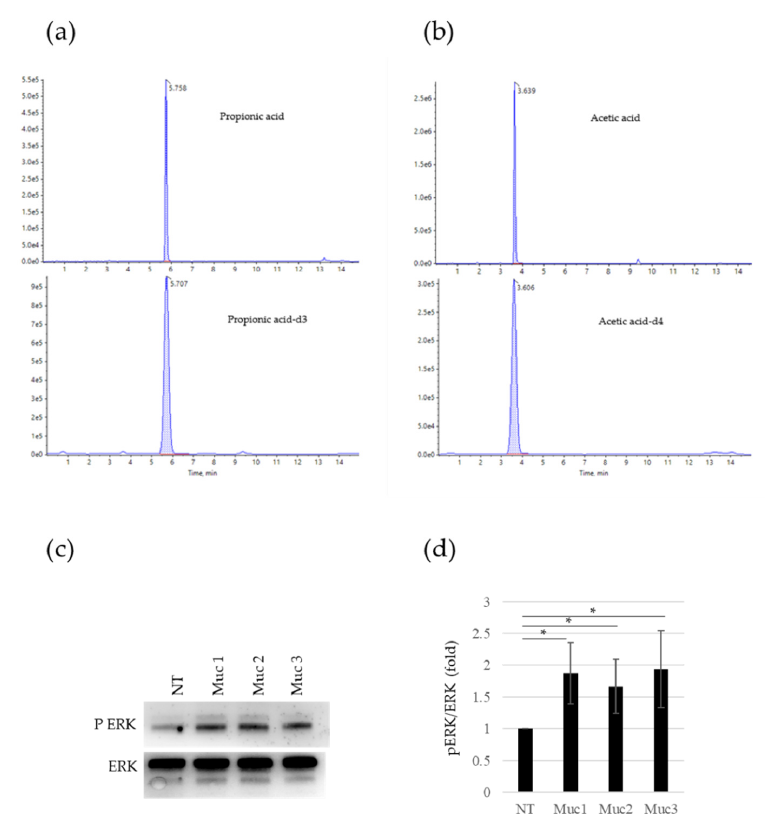
Figure 4. Activation of sperm cells by SCFAs in cervical mucus. ( a ) Plot shows a typical multiple- reaction-monitoring chromatogram of propionic acid (266.1–210.0) at the top and [2H 3 ] propionic acid (269.2–210.0) at the bottom of a cervical mucus sample with propionic acid. ( b ) Plot shows a typical multiple-reaction-monitoring chromatogram of acetic acid (255.1–209.9) at the top and [2H 4 ] acetic acid (255.1–211.0) at the bottom of a cervical mucus sample with acetic acid. ( c ) Representative Western blot (WB) analysis of pERK and total ERK protein in sperm cells after in vitro incubation for 10 min with cervical mucus obtained from three different healthy, fertile women. ( d ) Histogram shows the ratio of densitometric values of pERK to total ERK in sperm cells after in vitro incubation with cervical mucus. The densitometric value of untreated sperm cells (NT) is arbitrarily set to 1. Mean ± SD of three independent biological replicates are shown (n = 3. * = p < 0.05, one sample t